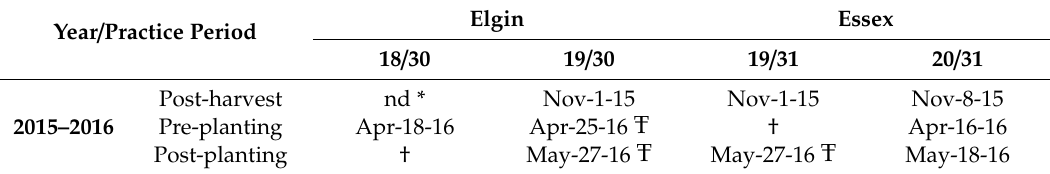
* nd—No ground data were collected due to cloud cover over the investigated area. † Ground data were collected but corresponding imagery was covered by